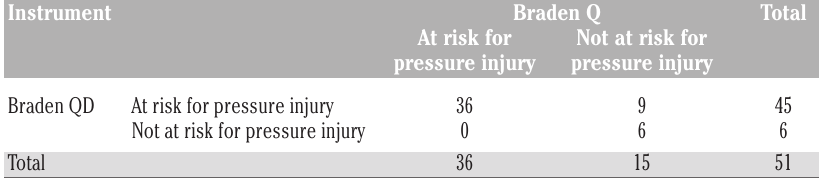
Table 4. Sensitivity and specificity test of Braden QD Scale on the Braden Q Scale in